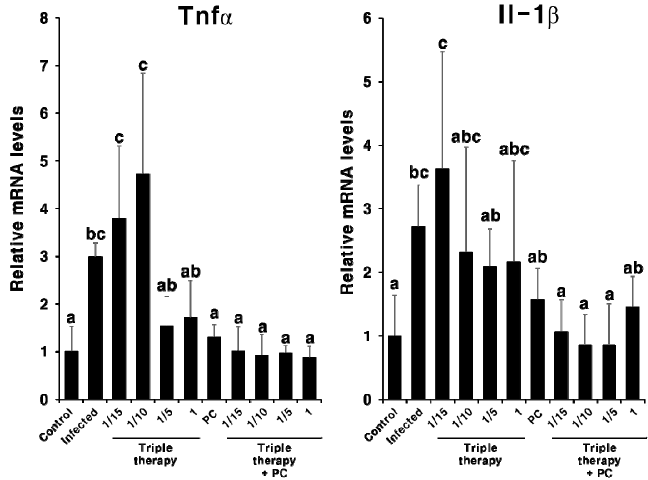
Figure 8. Expression levels of Tnf α and Il-1 β mRNA in the gastric tissue of the H. pylori -infected mice after combination treatment with PC and triple therapy. Different letters (a, b, and c) indicate a significant difference ( p < 0.05), ascertained via the Tukey–Kramer test. Triple therapy was administered at four concentrations. 1, Existing concentration of triple therapy (metronidazole and clarithromycin: 16.7 mg/kg; omeprazole: 700 μ g/kg); 1/5, one-fifth of the existing concentration of triple therapy; 1/10, one-tenth of the existing concentration of triple therapy; 1/15, one-fifteenth of the existing concentration of triple therapy. PC was administered at 1 mg/kg.